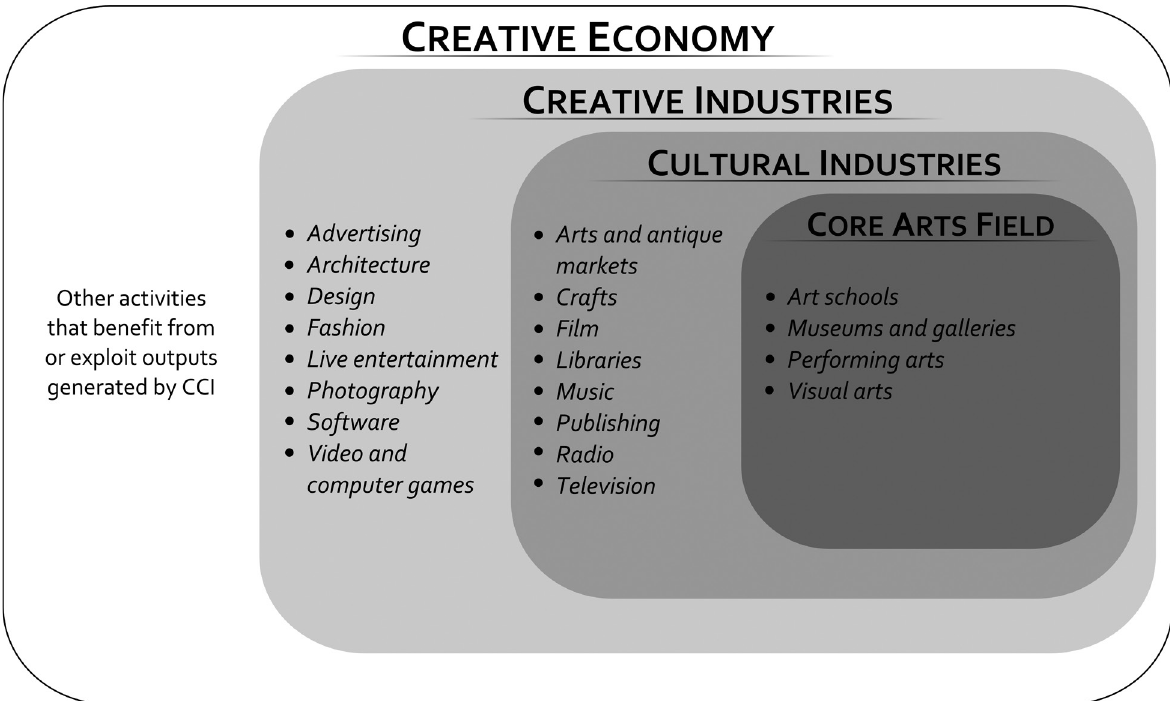
fig. 1. Cultural and creative industries and their place in the economy. Source: own compilation on the basis of KEA